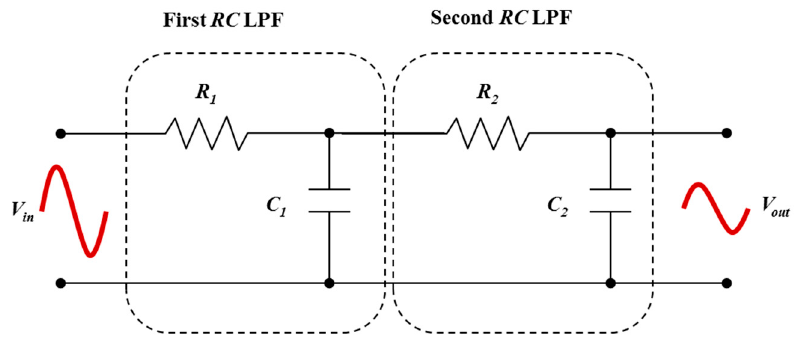
Figure 2. Illustration of cascading two first-order RC low pass filters (RC-FO1 and RC-FO2) to obtain second-order RC low pass filter a second-order RC low pass filter (RC-SO).